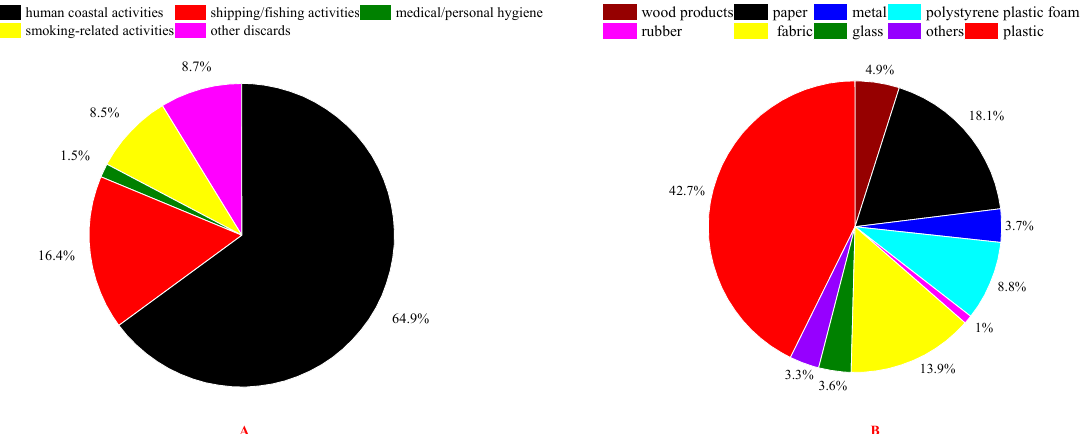
Figure 11. The average proportions of different components and sources of beach waste of twenty beaches in thirteen coastal cities around the Bohai Sea of China: sources of beach waste ( A ); compo- nents of beach waste ( B ).